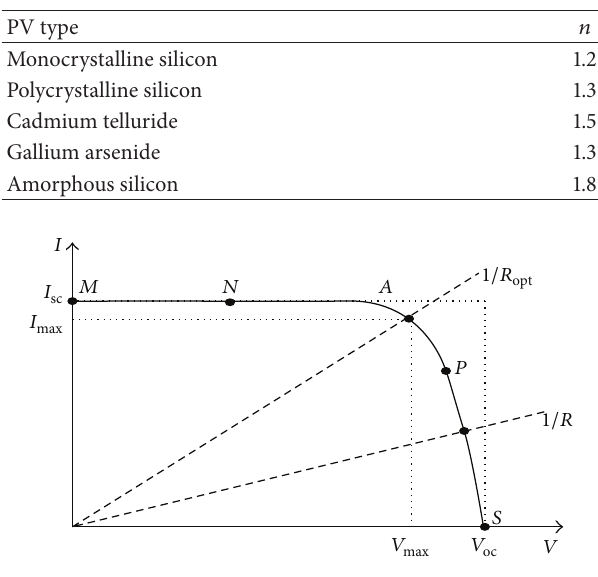
Figure 5: Specific 𝐼 - 𝑉 characteristics of solar